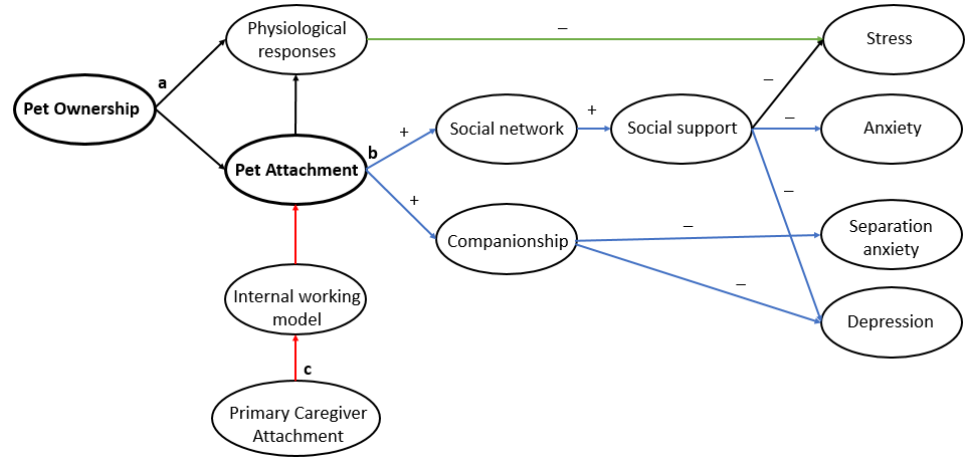
Figure 3. Hypothesized links for the impact of pet ownership and attachment on emotional health outcomes that postulates ( a ) physiological responses from pet interaction result in stress reduction (green pathway), and ( b ) anxiety, separation anxiety and depression are indirectly reduced by a wider social network and increased social support and companionship from pets (blue pathways) and ( c ) pet attachment may be indirectly affected by primary caregiver attachment (mother figure) through the internal working model (red pathway).